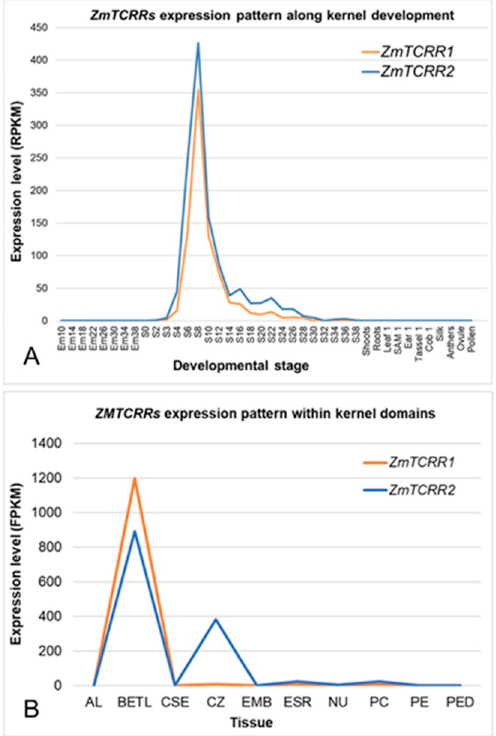
Figure 1. RNAseq expression analyses of ZmTCRR1 and ZmTCRR2. ( A ) The developmental expression pattern of these genes was analysed using the RNAseq data from the Chen et al. study [14]. Em10-38, embryo at the indicated DAP developmental stage; S0-38, kernel at the indicated DAP developmental stage. The last 11 samples represent other non-kernel plant tissues. SAM, shoot apical meristem. ( B ) The expression pattern of the genes was extracted from the 8 DAP RNAseq anatomical study by Zhan et al. [15]. Al, aleurone; BETL, basal endosperm transfer cell layer; CSE, central starchy endosperm; CZ, conductive zone; EMB, embryo; ESR, embryo surrounding region; Nu, nucellus; PC, placenta-chalaza; PE, pericarp; PED, pedicel.